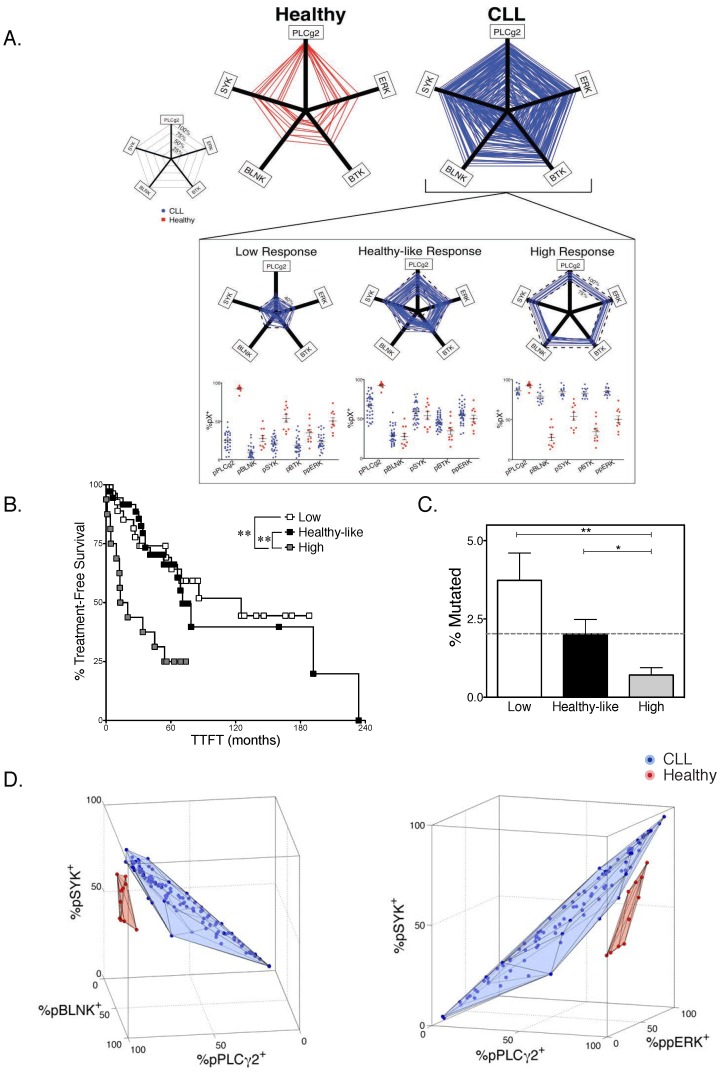
Variability in the Signaling Profile Allows Partioning of CLL Patients Into Distinct Prognostic Groups.A Graphic representation of all five phosphoresponses for CLL patients (blue, n = 110) as compared to the healthy controls (red, n = 11). A pentagon was created for each sample by connecting the percent of responding cells (over unstimulated control) recorded on the axes. A wide variability in extent of response was observed in the CLL group, encompassing all possible level of responsiveness. Three distinct groups of CLL could be defined based on the responsiveness (inset): patients with uniformly low response (left, at least 4 of the 5 pX+<40%), patients with uniformly high response (right, at least 4 pX+>75%), and patients with intermediate, healthy-like response (middle, at least 4 pX+ within the range of healthy samples). This groups of patients yielded n = 28 among low-responders, n = 36 among intermediate (healthy-like) responders and n = 17 among high-responders. B Kaplan-Meyer curves showing time from diagnosis to first treatment (TTFT) was plotted for the three distinct CLL subgroups described in D. Patients whose phosphoprofile consists of uniformly high phosphoresponses had a statistically significant (p<0.01) shorter time to first treatment (TTFT). Furthermore, high responders had a larger fraction that had required treatment (p<0.04). Those patients whose %pX+ values were uniformly low or similar to healthy individuals across the 5 responses studied had a significantly longer time to first treatment, and fewer patients within this cohort have required treatment at the time of this analysis. C Distinct IGHV status (% deviation from germline sequence) is also observed between these three subgroups. The dashed line indicates the 2% cutoff for mutational status, mutated vs. unmutated. Mean ± Std. Error % Mutated: Healthy-like = 2.02±0.43; High = 0.73±.21; Low = 3.9±.86. D Three-dimensional visualization of three phosphoresponses ([%pPLCγ2+, %pBLNK+ and %pSYK+], or ([%pPLCγ2+, %pSYK+ and %ppERK+]) for (blue) all CLL and (red) healthy samples. Each panel demonstrates the clear separation of the healthy patient samples from the CLL patient samples solely by virtue of the combined %pX+ values for the three phosphoresponses.